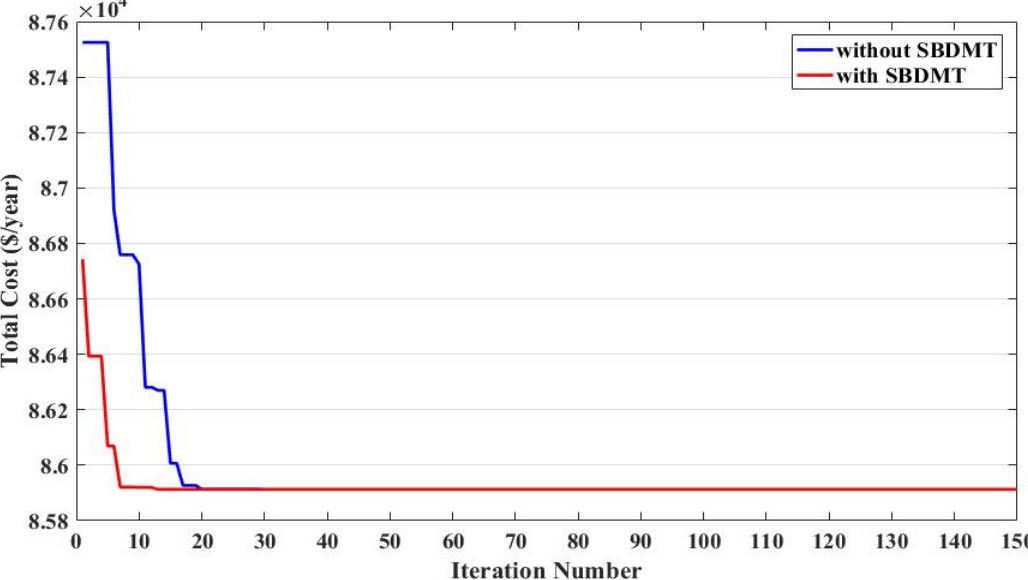
Figure 3. Convergence characteristics of PODESCA for the 69-bus system.